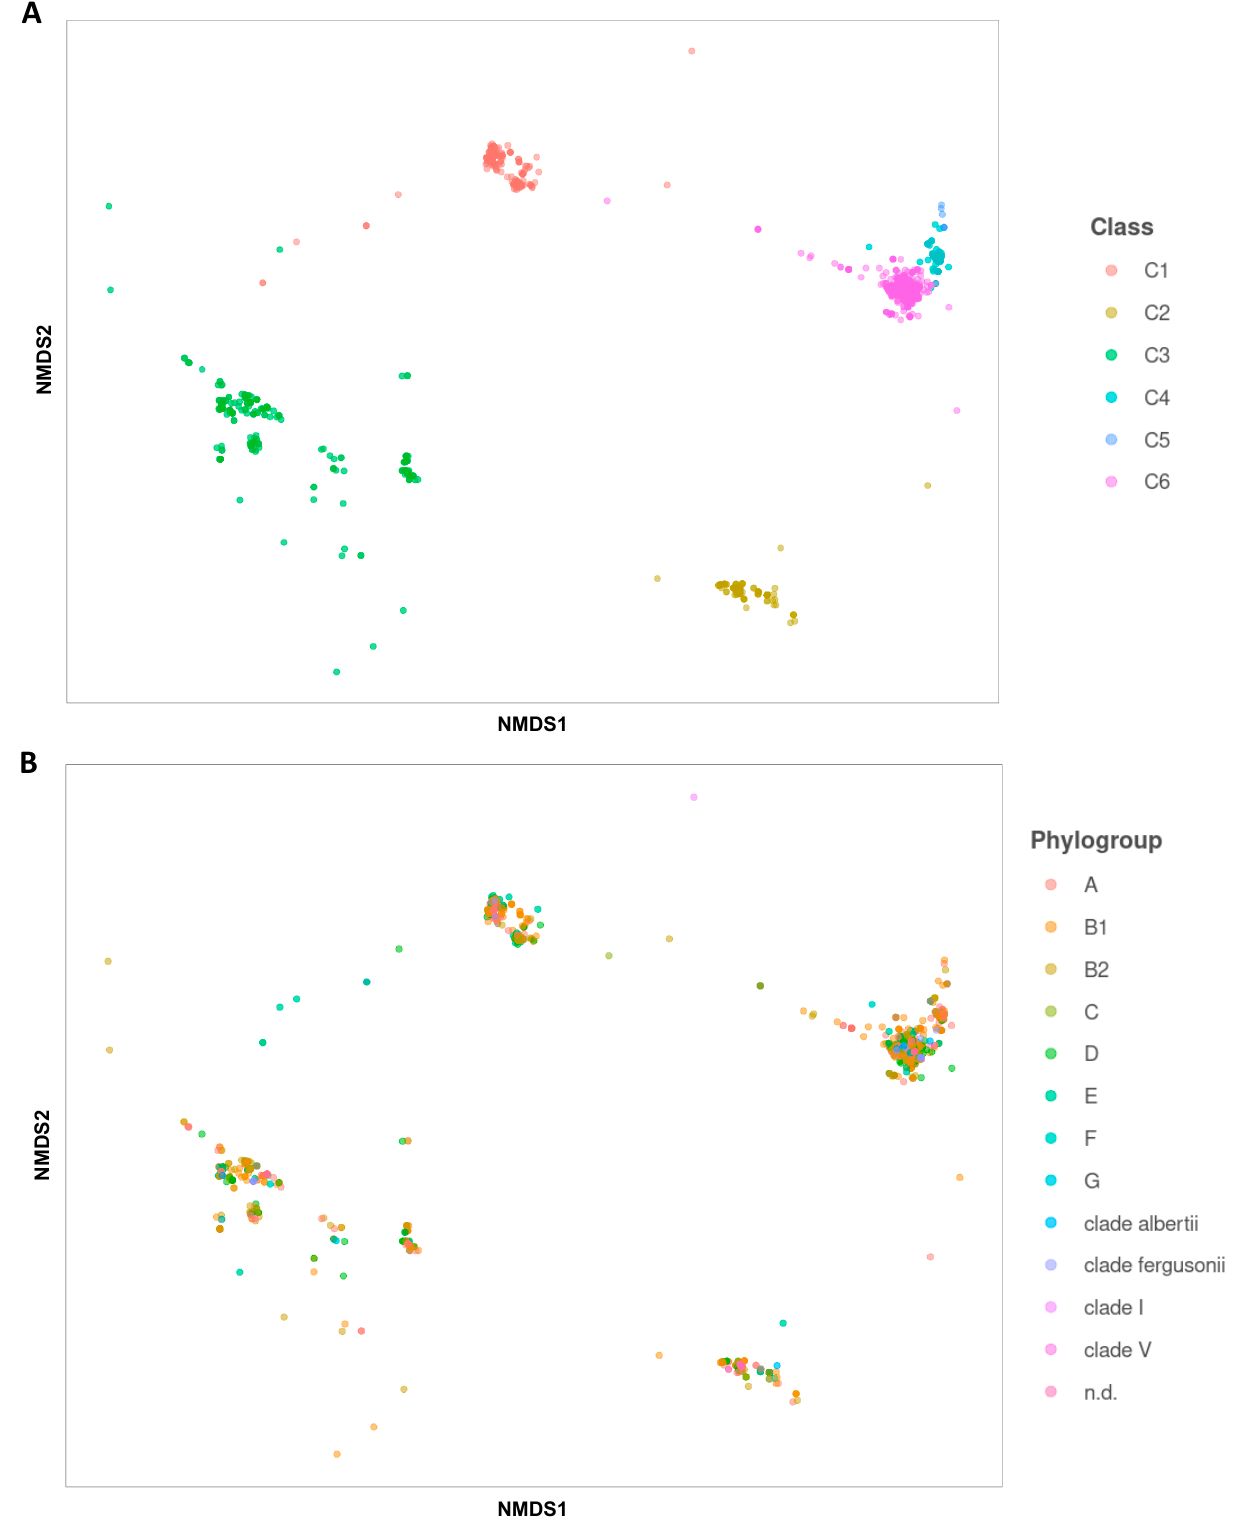
Figure 10. NMDS (non-metric multi-dimensional scaling) ordination plots of the relationships between Escherichia phylogroups and Ag43 classes. PERMANOVA (permutational multivariate analysis of variance) was performed to analyse the variance between genomic sequences and the phylogenetic tree of Ag43 passenger sequences. ( A ) NMDS highlighting the different Ag43 classes respective to dissimilarity matrix of Ag43 passenger sequences. ( B ) NMDS highlighting the different phylogroups respective to a dissimilarity matrix of Ag43 passenger sequences.